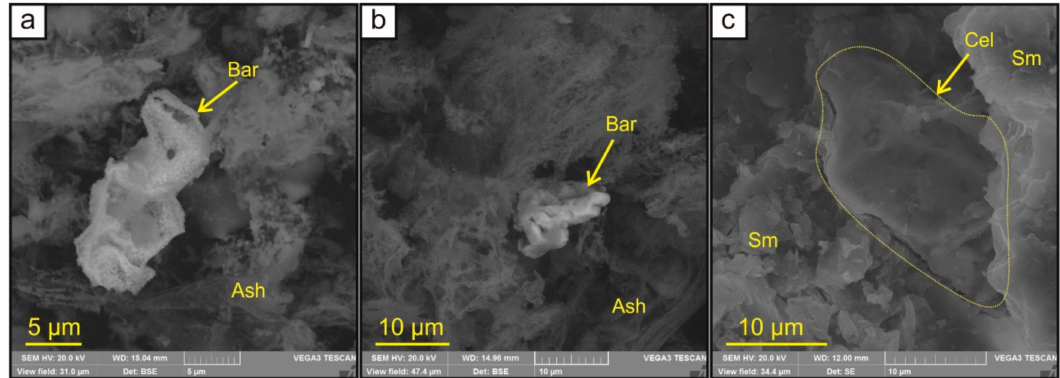
Figure 4. SEM images of Ba- and Sr-sulfate in peat: ( a ) anhedral barite (Bar) in ash; ( b ) subhedral barite in ash; ( c ) anhedral celestine (Cel) in smectite (Sm) matrix. The images are ( a , b ) backscattered and ( c ) secondary electron